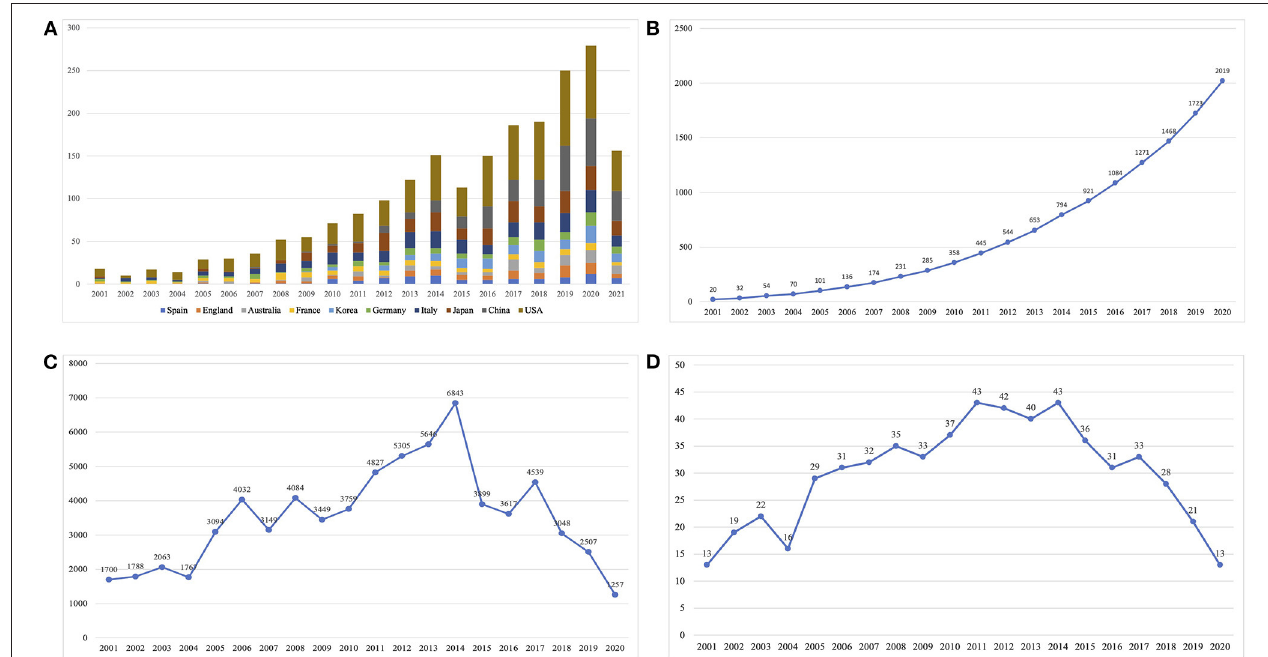
FIGURE 2 | The number of publications, the number of citations, and the Hirsch index (H-index) for chemotherapy-induced peripheral neuropathy (CIPN): (A) the annual number of publications in major countries; (B) the annual cumulative number of publications; (C) the annual citation number of publications, and (D) the annual H-index of publications.